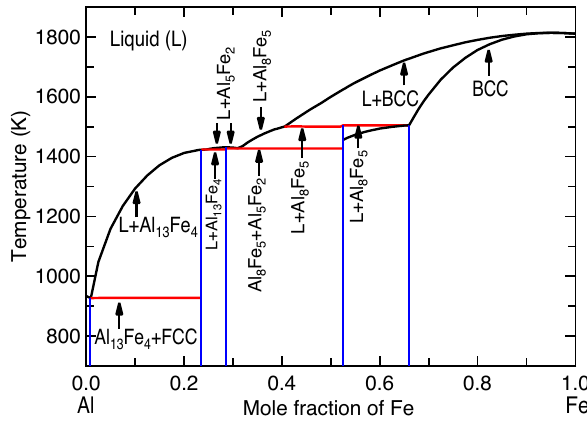
Figure 9. Predicted Al–Fe non-equilibrium phase diagram by Scheil simulations uisng the modelled data by Sundman et al. 9 , showing the forming temperatures for the phases indicated by the lines. Note that the lever rule cannot be used to determine phase fractions (see Fig. 8 for two examples).